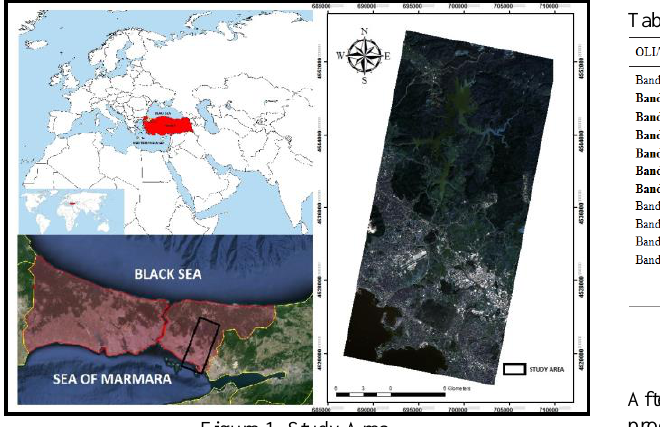
Figure 1. Study Area